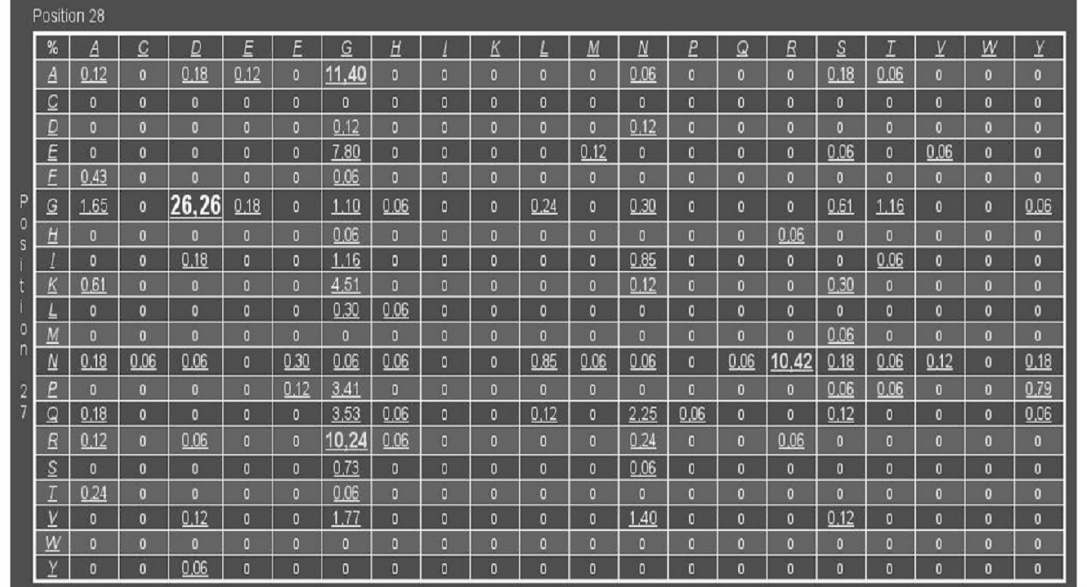
Figure 1. Residue pair frequency table of amino acid couple 27 and 28 (3DM numbering). In wild-type cupin-type P. furiosus phosphoglucose isomerase (PfPGI), these residues correspond to Pro132 and Tyr133. The correlated mutation analysis (CMA) scores are shown and are relative to the number of unique sequences containing such occurrences in the superfamily alignment.